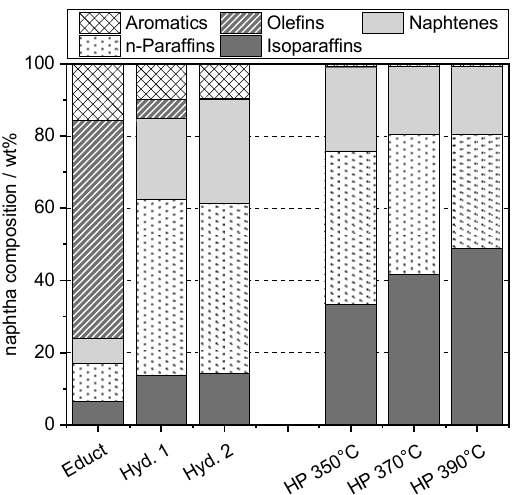
Figure 13. Naphtha composition after the subsequent hydrogenation steps and individual hydroprocessing at different temperatures.